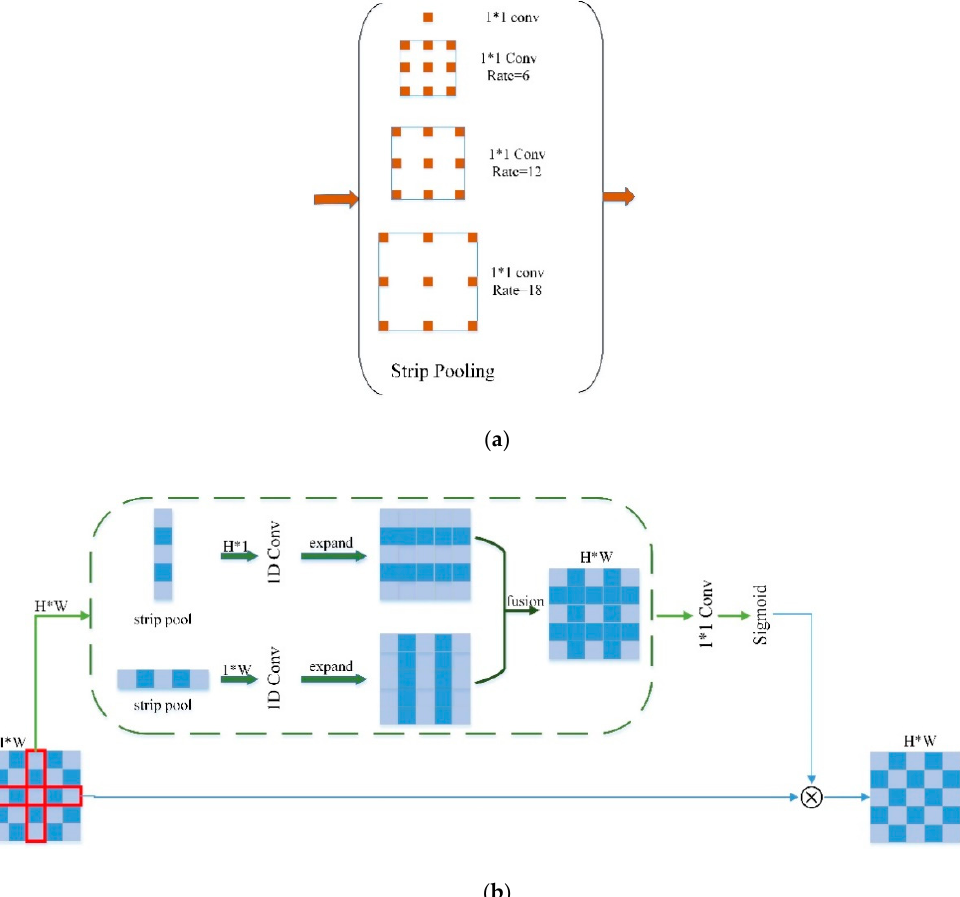
Figure 3. The improved ASPP structure, composed of atrous convolution and strip pooling. ( a ) The overall structure of the improved ASPP structure. ( b ) Strip pooling structure diagram.